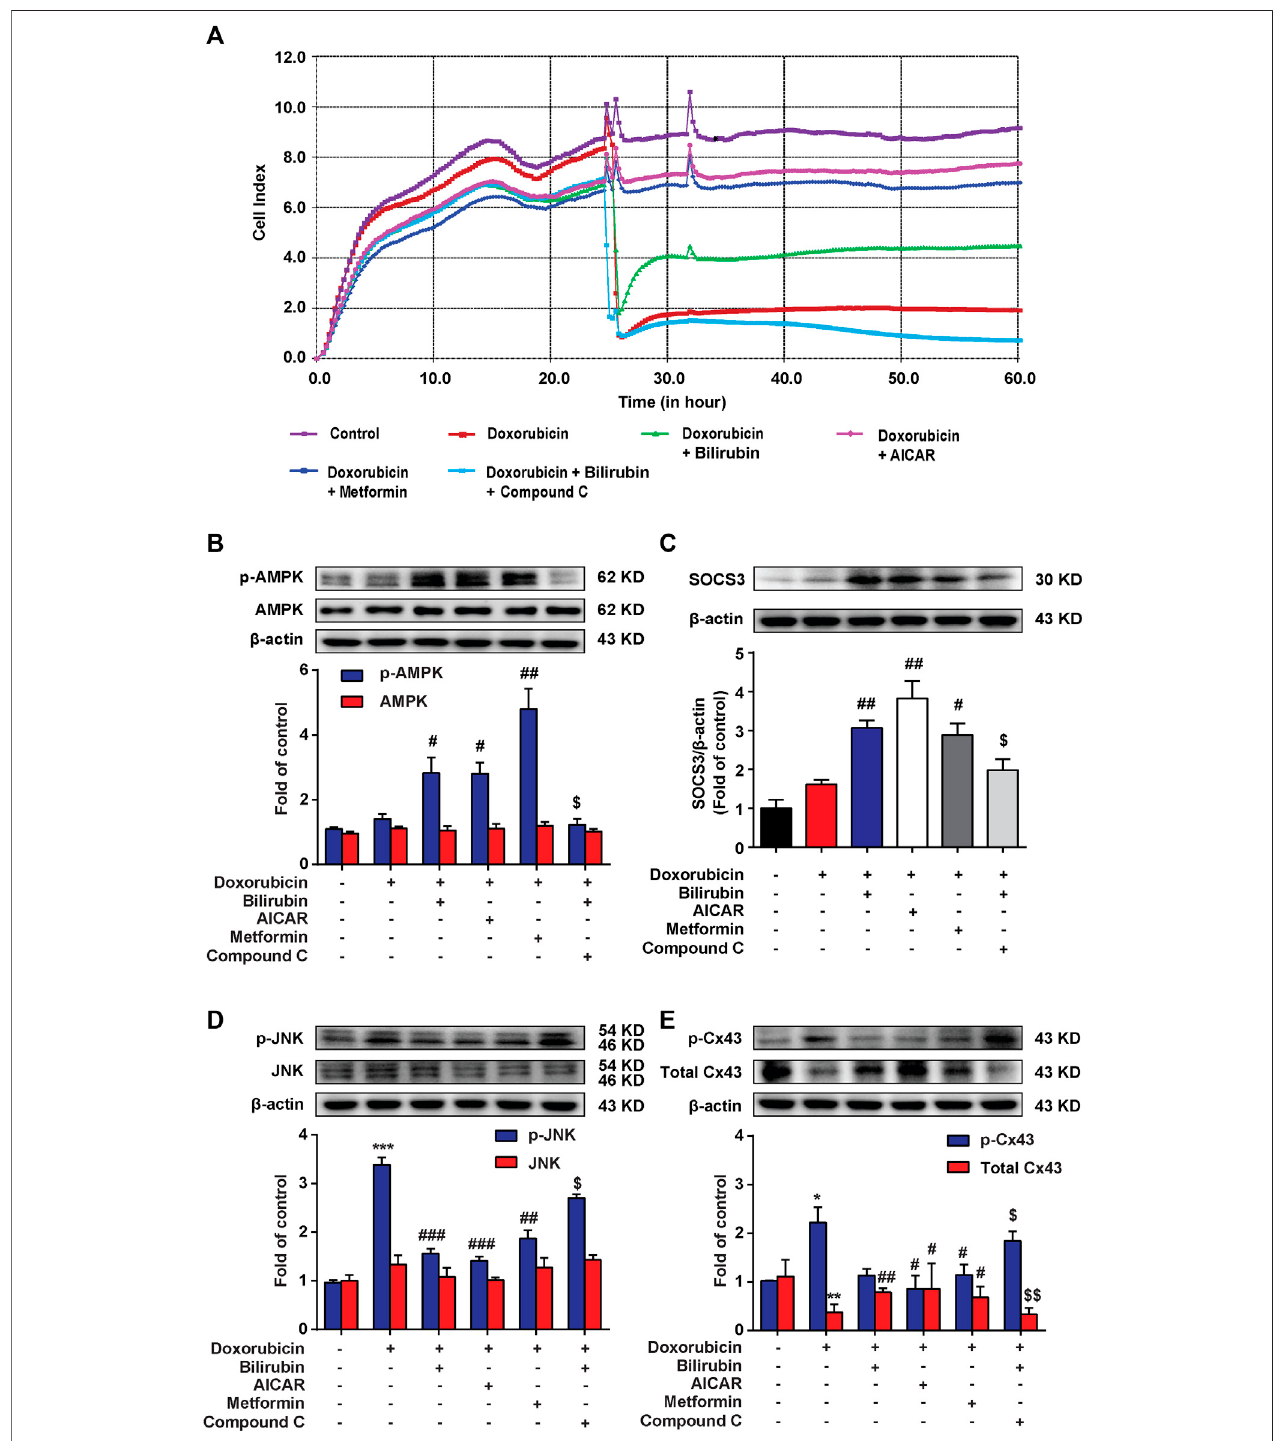
FIGURE 5 | Bilirubin protects against Doxorubicin-induced cardiotoxicity in an AMPK-SOCS3 dependent manner in H9C2 cells. (A) RTCA (xCELLigence platform) wasusedtorecordthecellgrowthcurvesinH9C2cells. (B – E) Representativewesternblotbandsshowedthelevelsofp-AMPK,AMPK,SOCS3,p-JNK,JNK,p-Cx43, and total Cx43 in H9C2 cells in vitro . H9C2 cells were pretreated with Compound C (2 μ M) for half an hour before bilirubin treatment, and then cells were cultured with bilirubin (0.1 μ M), AICAR (20 μ M) and metformin (1 mM) for 6 h, followed by doxorubicin treatment (1 μ M) for another 24 h. The western blot samples were collected and analyzed ( n = 4 of each group). Signi fi cant difference was revealed following one-way ANOVA (* p < 0.05, *** p < 0.001 vs. Control group; # p < 0.05, ## p < 0.01, ### p < 0.001 vs. Doxorubicin-treated group; $ p < 0.05 vs. Doxorubicin and bilirubin-treated group; Bonferroni post hoc tests).